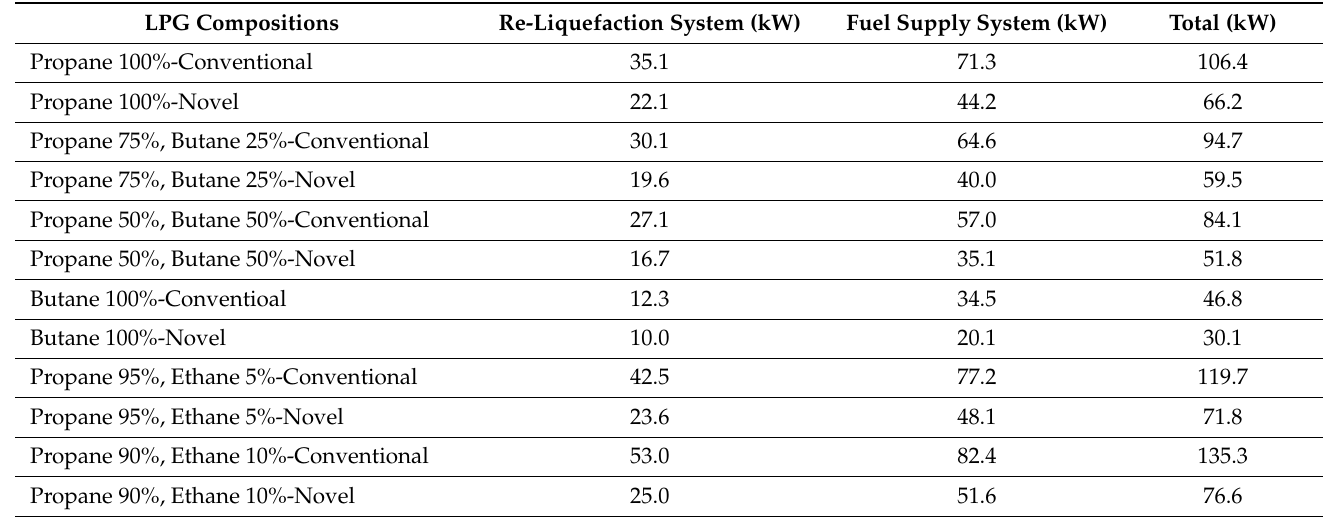
Table 6. Energy consumption for conventional and novel re-liquefaction and fuel supply systems in LPG carriers with LPG composition.